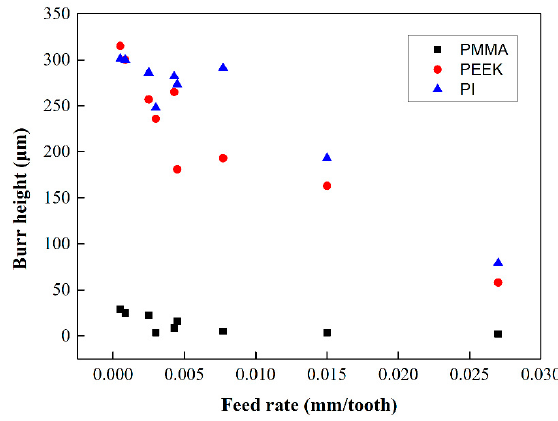
Figure 8. Burr height of the grooves for different polymers (tool diameter of 0.5 mm).